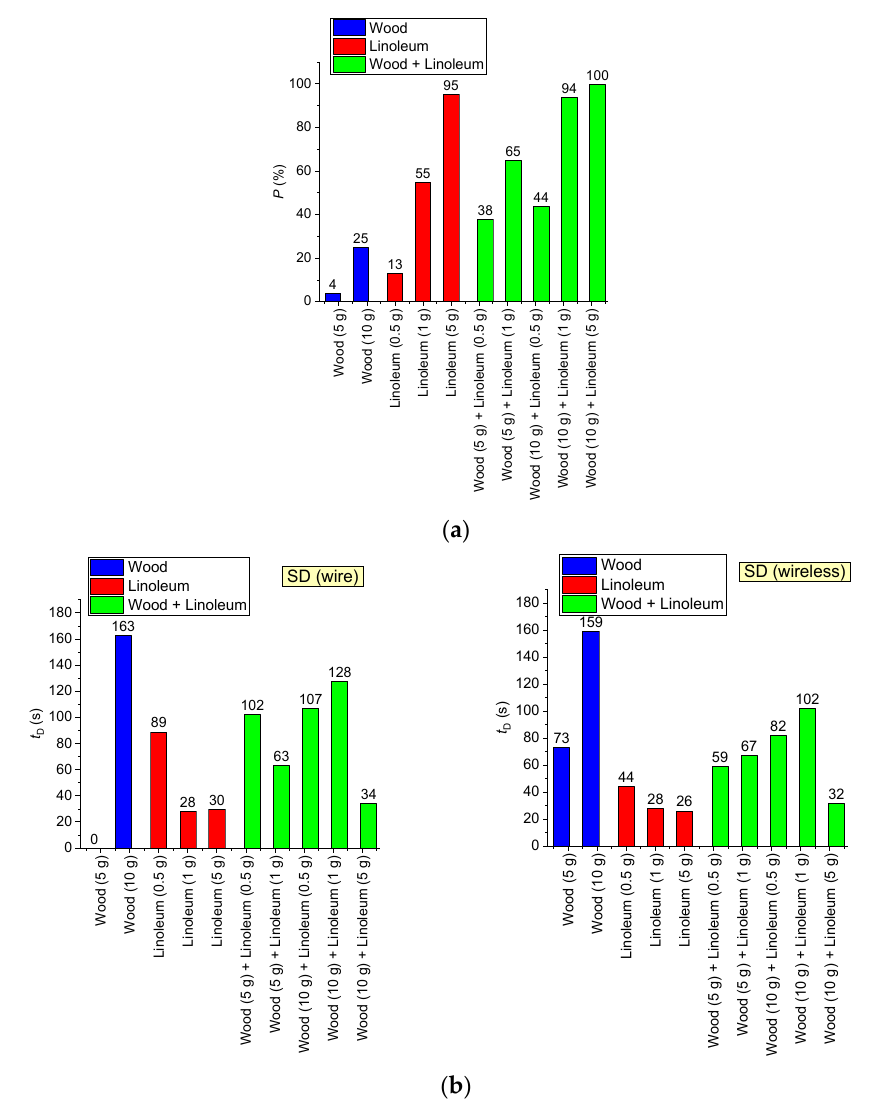
Figure 23. Probability ( a ) and delay ( b ) of SD activation for different combinations of combustible materials.